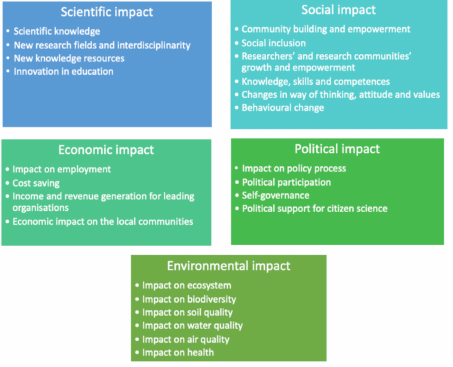
Figure 2. ACTION impact assessment areas and